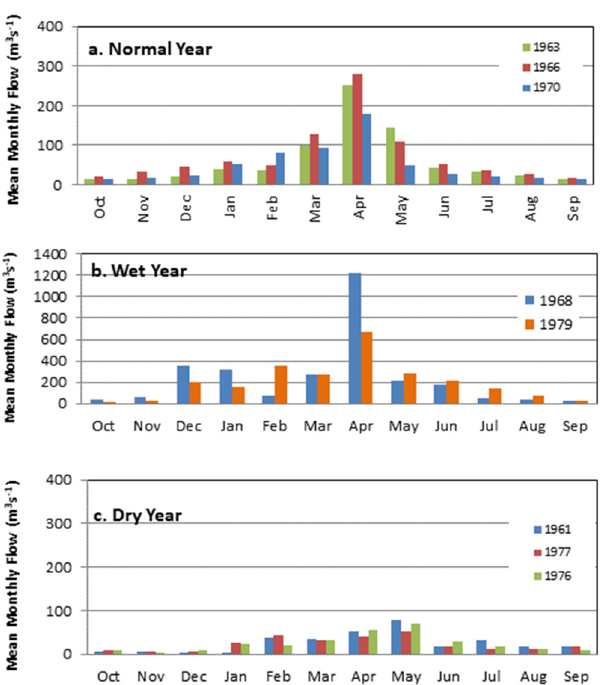
Figure 3. Mean Monthly Discharge (m 3 /s) in ( a ) normal, ( b ) wet and ( c ) dry years at Gama Gate, Wami River, Tanzania.